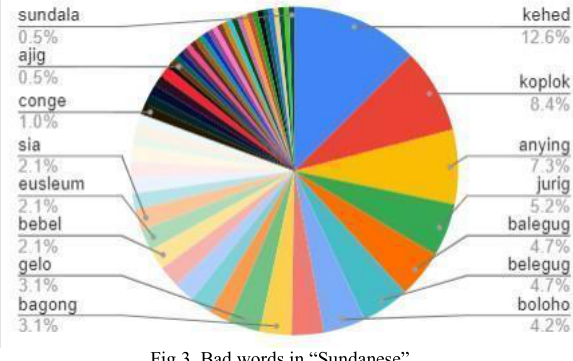
Fig 3. Bad words in “Sundanese”